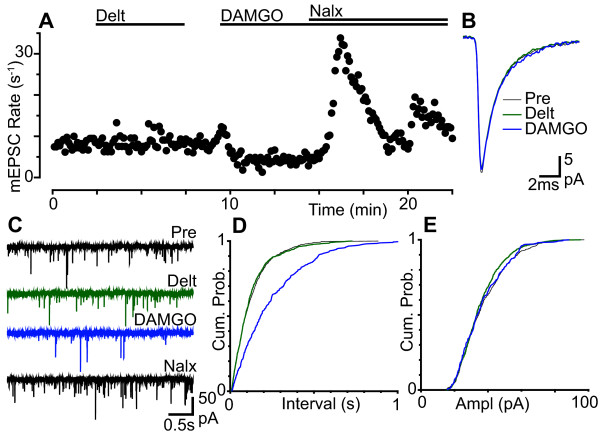
μ-Opioids presynaptically inhibit basal glutamatergic transmission in superficial dorsal horn neurons. (a) Time plot of miniature EPSC (mEPSC) rate during superfusion of deltorphin-II (Delt, 300 nM), DAMGO (3 μM) and naloxone (Nalx, 1 μM). (b) Averaged traces and (c) raw current traces of mEPSCs prior to (Pre), and during deltorphin-II, DAMGO and naloxone. Cumulative probability distribution plots of mEPSC (d) inter-event interval and (e) amplitude for the epochs averaged in (b) (number of events = 635, 640, 327 for control, deltorphin-II and DAMGO, respectively, over 80 s intervals). (a) - (e) are taken from one neuron.